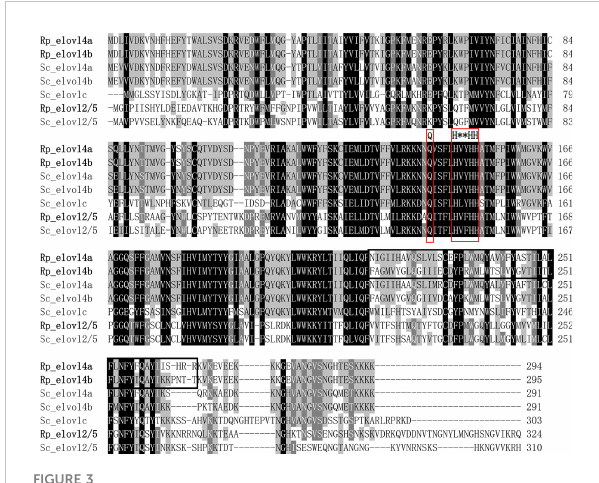
FIGURE 3 Alignment of the deduced aa sequences of Rp_elovl2/5 , Rp_elovl4a and Rp_elovl4b and with Elovl2/5 (Sc_elovl2/5, QCF41170.1), Elovl4 (Sc_elovl4a, QCF41171.1; Sc_elovl4b, QCF41172.1) and a novel Elovl with Elovl4 activity (Sc_elovlc, QCF41173.1) from S. constricta by using ClustalX 1.83. The histidine box (H**HH) and diagnostic “ Q ” conserved in LC-PUFA elongase are highlighted with red frames. The different aa domains between Rp_elovl4a and Rp_elovl4b are indicated with a bold line